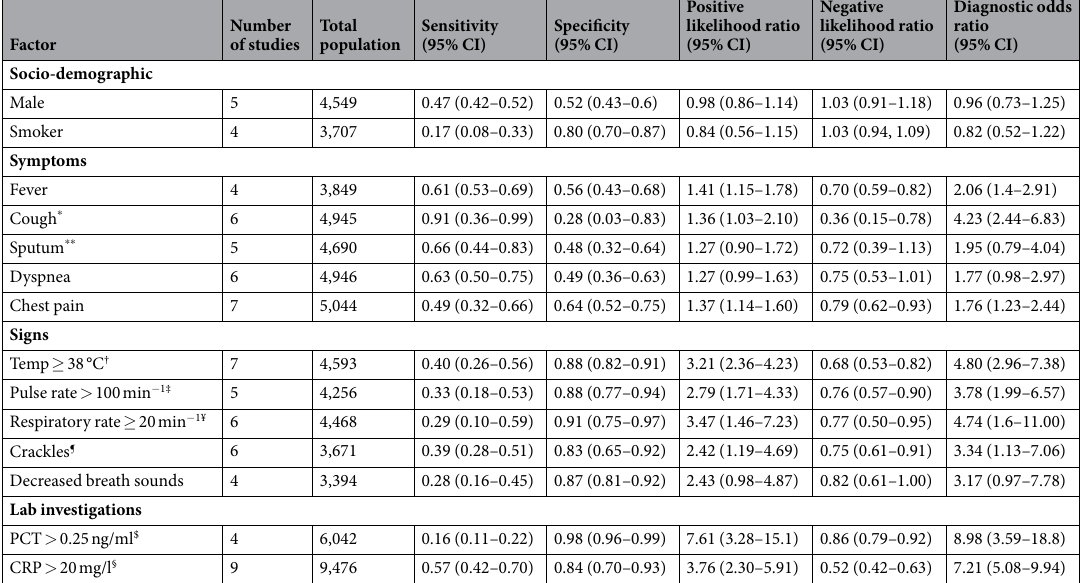
Table 2. Summary estimates of diagnostic performance measures of each index test assesses in four studies or more. * Dry cough in one study is included. ** Yellowish purulent sputum in three studies are included. † Temperature ≥ 37.8 °C in two studies are included. ‡ Pulse rate ≥ 100 min − 1 in one study is included. ¥ Respiratory rate ≥ 22 min − 1 in one study, respiratory rate ≥ 24 min − 1 in two studies are included. ¶ Rales in two studies are included. $ PCT > 0.50 ng/ml in two studies are included. § CRP > 50 mg/l in two studies and CRP > 100 mg/l in three studies are